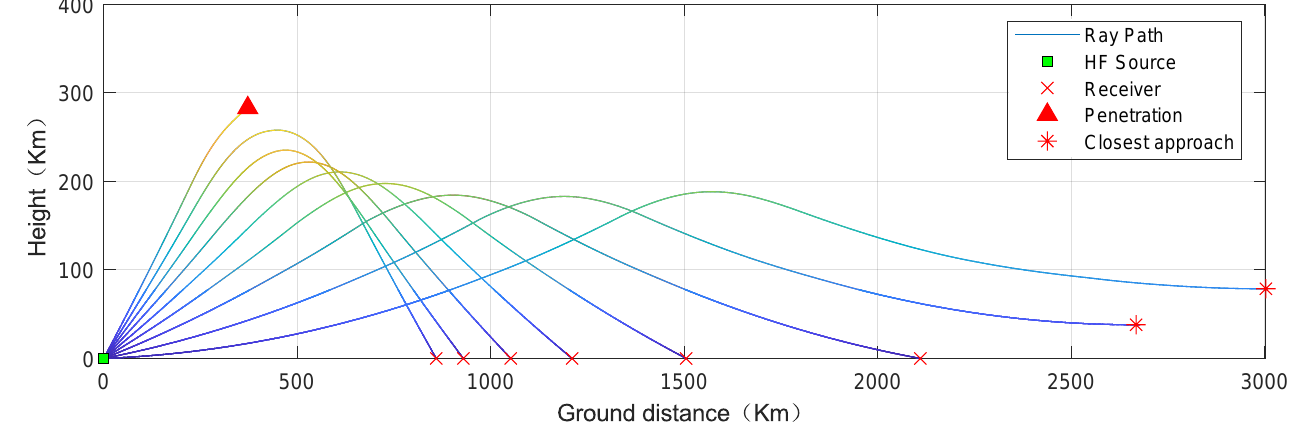
Figure A3. Simulation of HF signal ray tracing with different emission angles and a fixed signal frequency of 7.23 MHz.